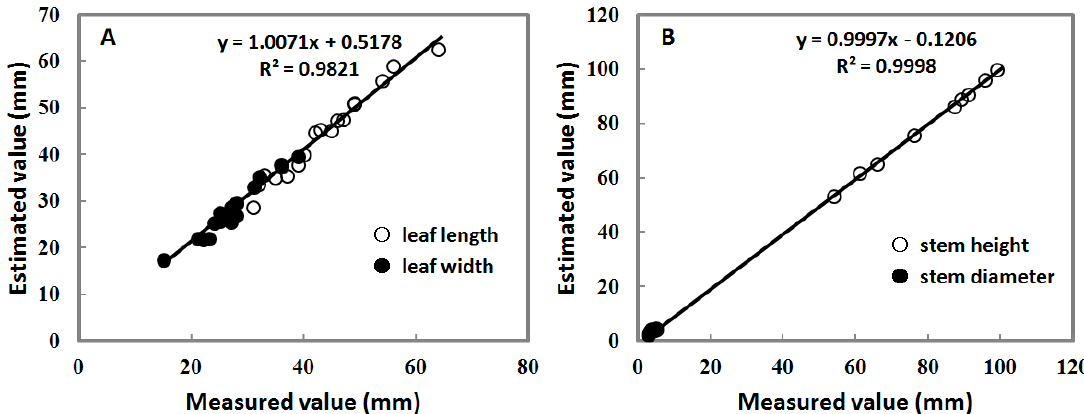
Figure 6. The accuracy of the best 3D models for leaf and stem shapes of paprika plants taken by the 28-mm lens. ( A ) Leaf length and width of plants taken at the first camera position; ( B ) Stem heights and diameters of plants taken at the third camera position.